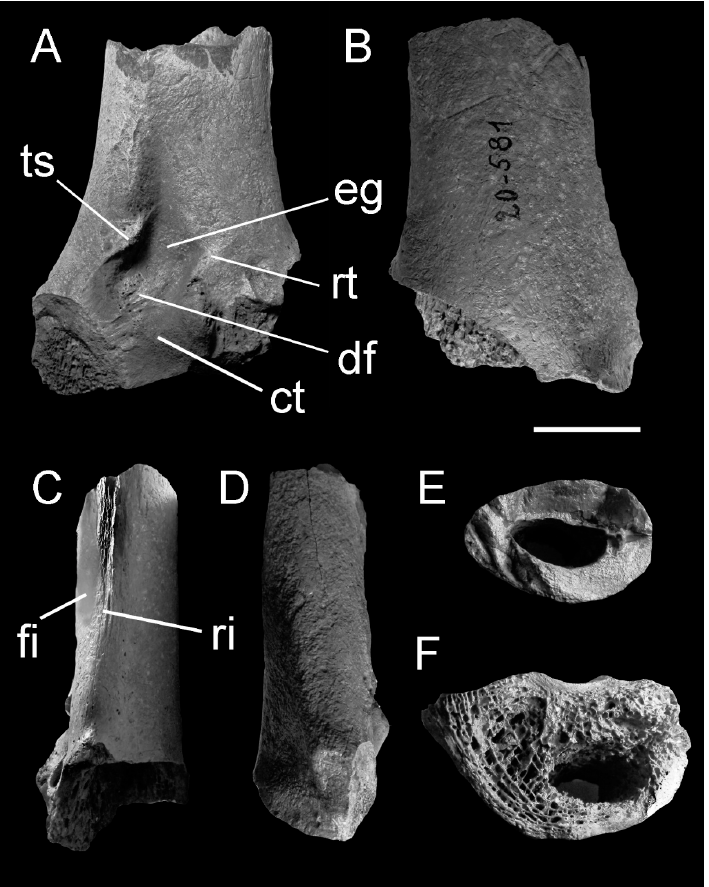
Figure 3. Brontornis burmeisteri (MLP 20-581) distal end of left tibiotarsus in ( A ) anterior; ( B ) posterior; ( C ) lateral; ( D ) medial; and ( F ) distal views; and ( E ) cross section of the shaft. Abbreviations . ct, central tubercle for the lig. meniscotibiale intertarsi ; df, distal fossa; eg, extensor groove; fi, surface for fibula; ri, proximodistally extended lateral ridge; rt, possible lateral retinacular tubercle; ts, ridge representing medial retinacular tubercle. Scale bar: 5